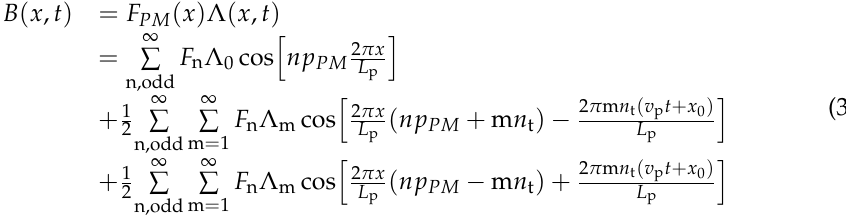
( b ) Figure 3. Analysis of air gap flux density and its harmonic generated by armature winding: ( a ) Air gap magnetic density ( b ) Harmonic content in air gap. 3. Design of Staggered Tooth Modular Generator 3.1. Structure of Modular LPMVG A modular structure is proposed to reduce the cogging force of the linear permanent magnet vernier wave generator [10]. 3.2. Cogging Force of Actuator Modularization The edge force of each module of the generator is as follows _